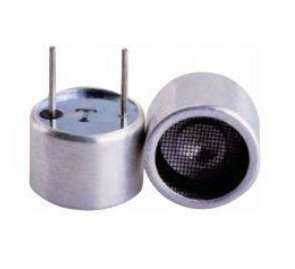
Fig. 3. Ultrasonic transmitters/ recievers chosen for testing.